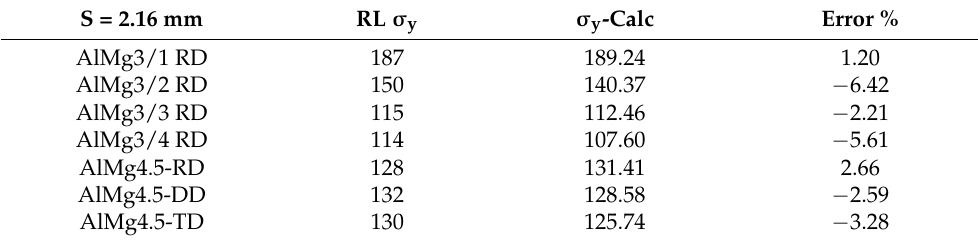
Table 4. Comparison of measured and calculated yield strength